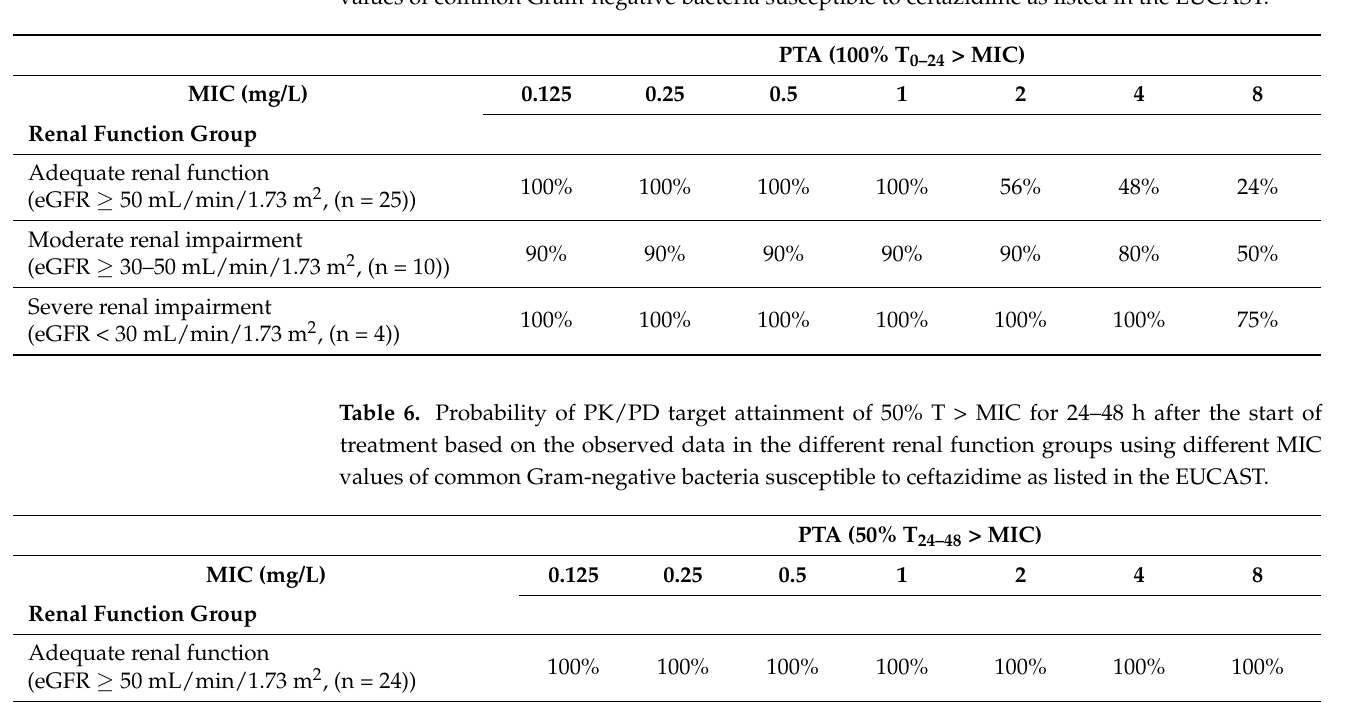
Table 5. Probability of PK/PD target attainment of 100% T > MIC for the first 24 h after the start of treatment based on the observed data in the different renal function groups using different MIC values of common Gram-negative bacteria susceptible to ceftazidime as listed in the EUCAST.